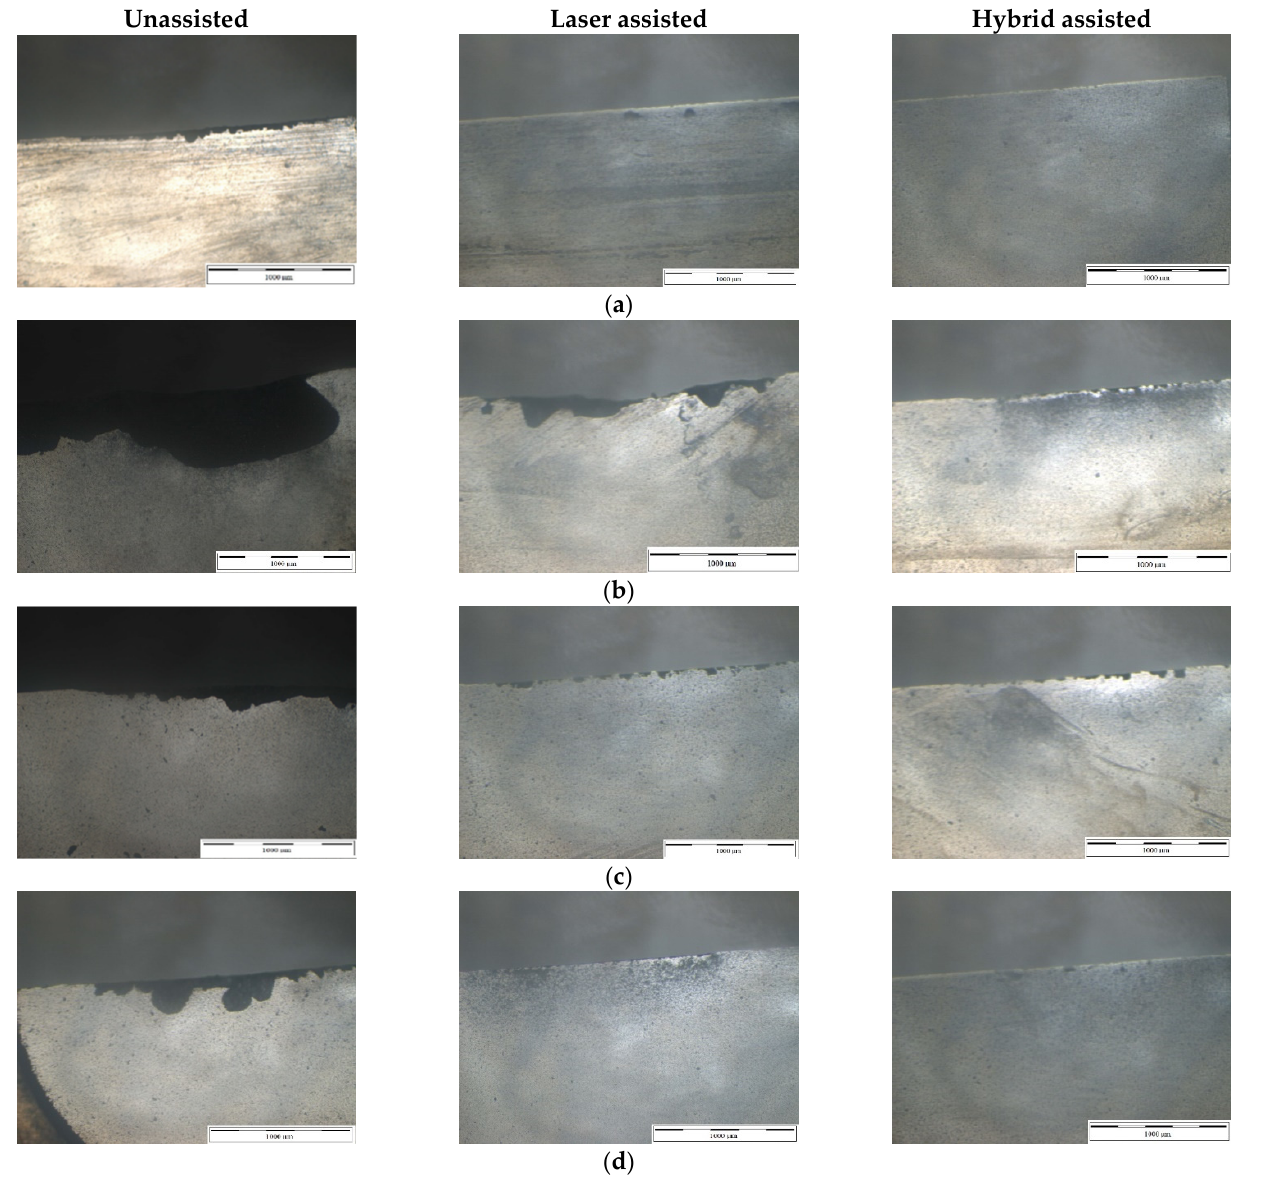
Figure 11. Surface morphology of milling cutters at ( a ) n = 6000 rpm, a e = 0.02 mm, and F = 500 mm/min; ( b ) n = 6000 rpm, a e = 0.10 mm, and F = 1500 mm/min; ( c ) n = 9000 rpm, a e = 0.06 mm, and F = 1000 mm/min; and ( d ) n = 12,000 rpm, a e = 0.02 mm, and F = 1000 mm/min.